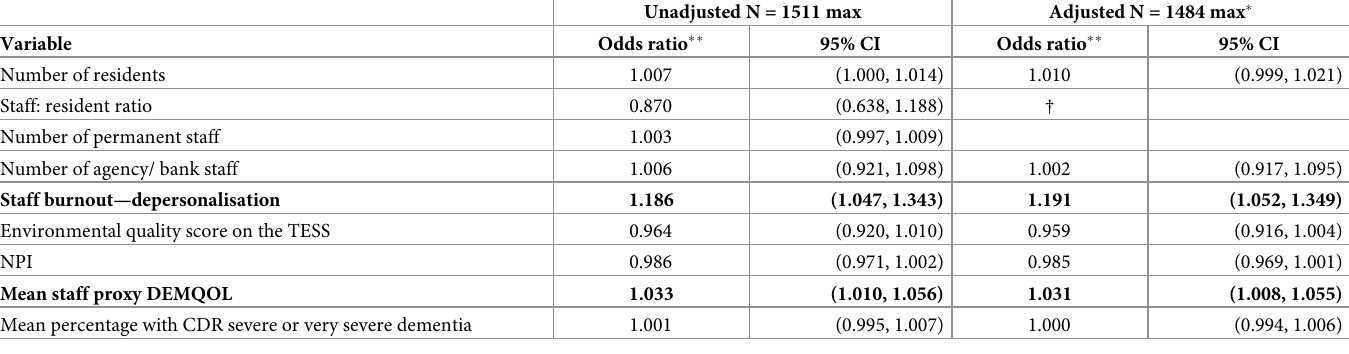
Table 5. Adjusted and unadjusted associations of proportion of staff reporting abusive behaviours (cid:3) occur at least sometimes and other factors studied (p < 0.05 in